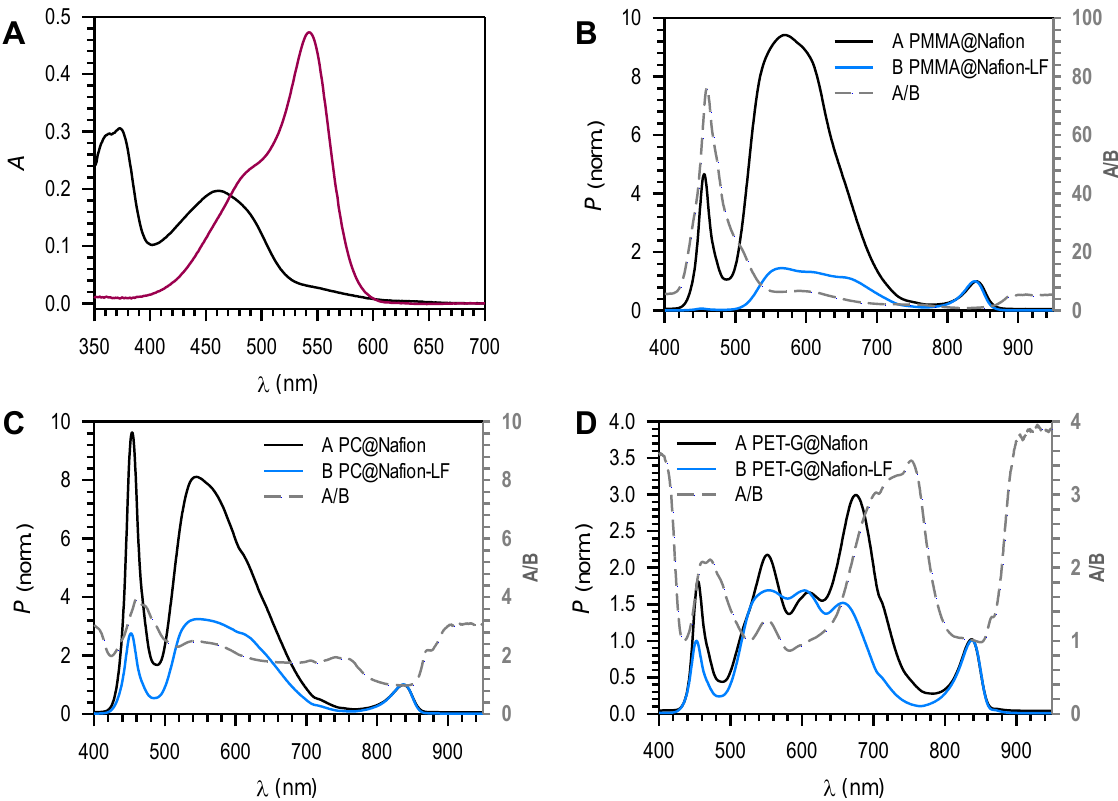
Figure 5. ( A ) Absorption spectra of aqueous solutions of the violet product (0.08 mmol L ⁻ 1 , purple line) and of LF (0.6 mmol L ⁻ 1 , black line) recorded in a Varian Cary 3Bio spectrophotometer. ( B – D ) Normalized (at 840 nm) transmission spectra of three EWOFS manufactured from Nafion-coated PMMA, PC and PET-G filaments in the presence (blue lines) and in the absence (black lines) of LF indicator in the cladding. The gray dashed lines represent the ratio between the reference and the OFS spectra. Spectral acquisition parameters: 40 ms (PMMA), 1 ms (PC) and 10 ms (PET-G) exposure times; boxcar 7; 10 scans per spectrum.